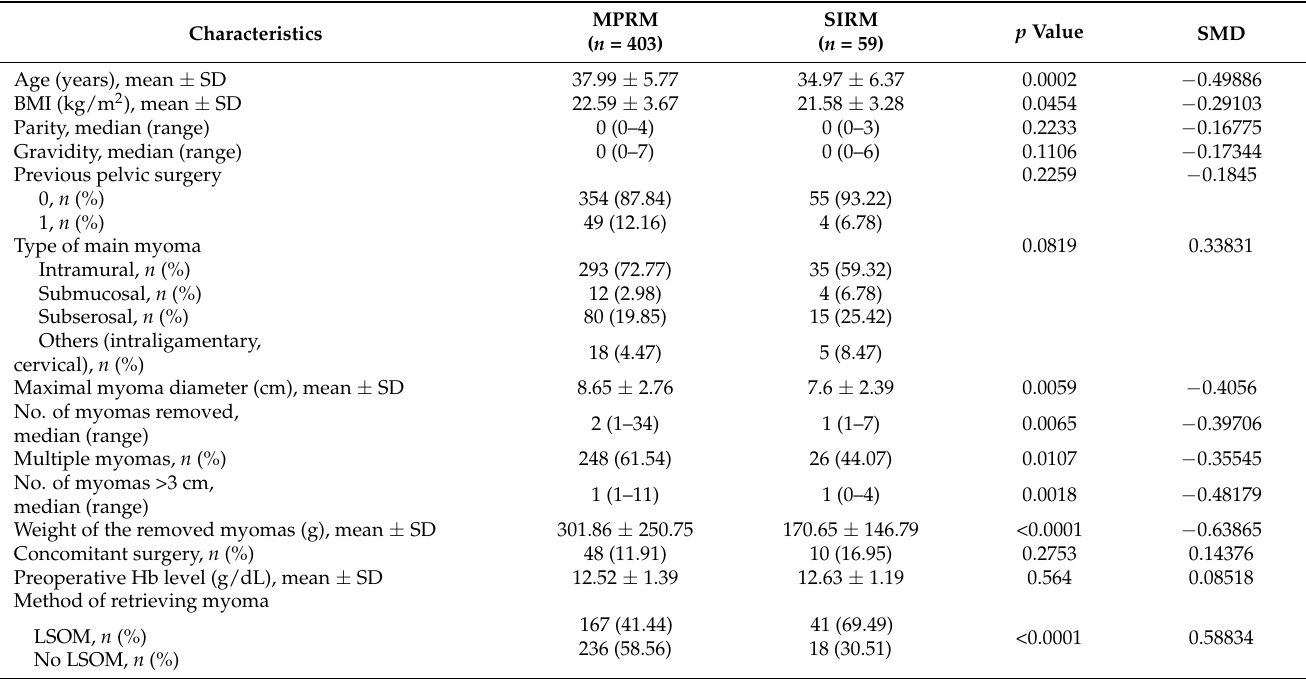
Table 1. Baseline and preoperative patient